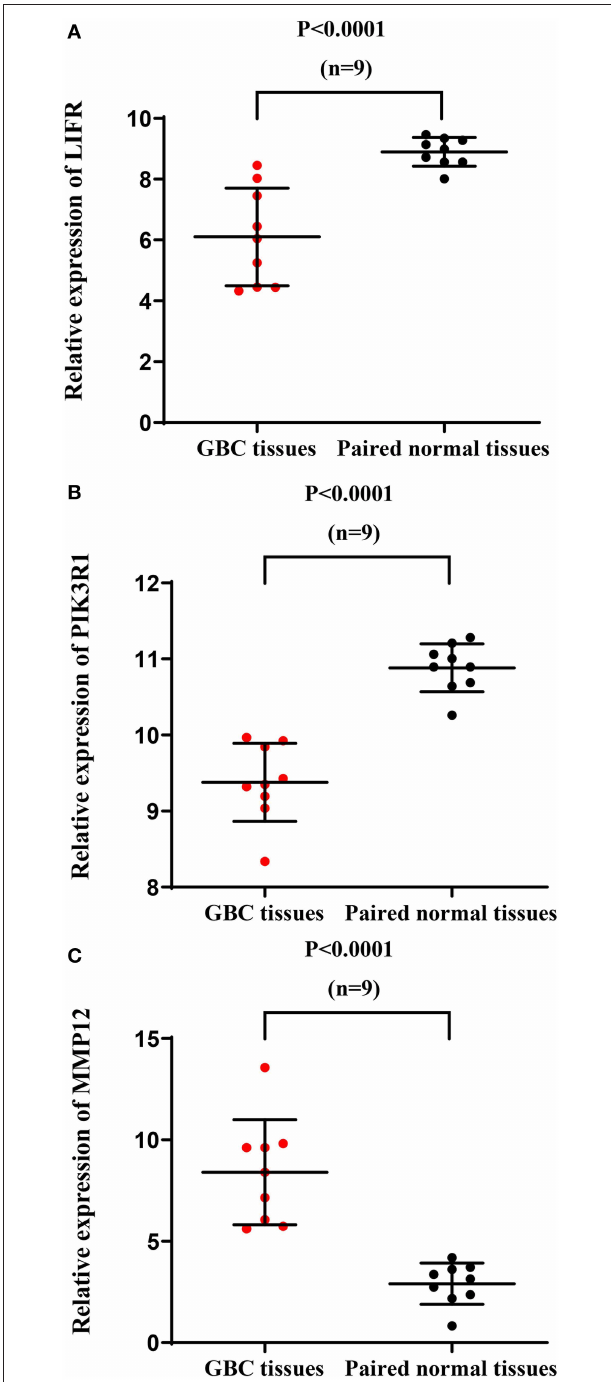
FIGURE 7 | mRNA expression of LIFR , PIK3R1, and MMP12 in an independent GBC dataset (GSE76633). mRNA expression profile of LIFR (A) , PIK3R1 (B) , and MMP12 (C) across tumor samples and paired normal tissues.